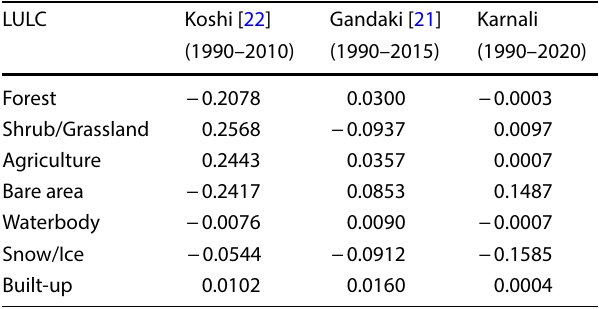
Table 8 Annual LUCC rate in the three major rivers basins of Nepal (in %) LULC Koshi